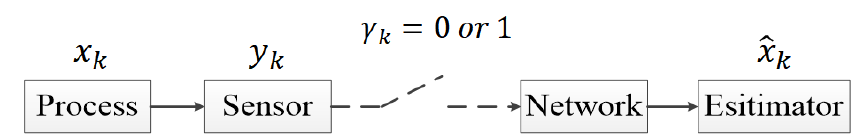
Figure 1. Event-triggered sensor scheduling diagram for remote state